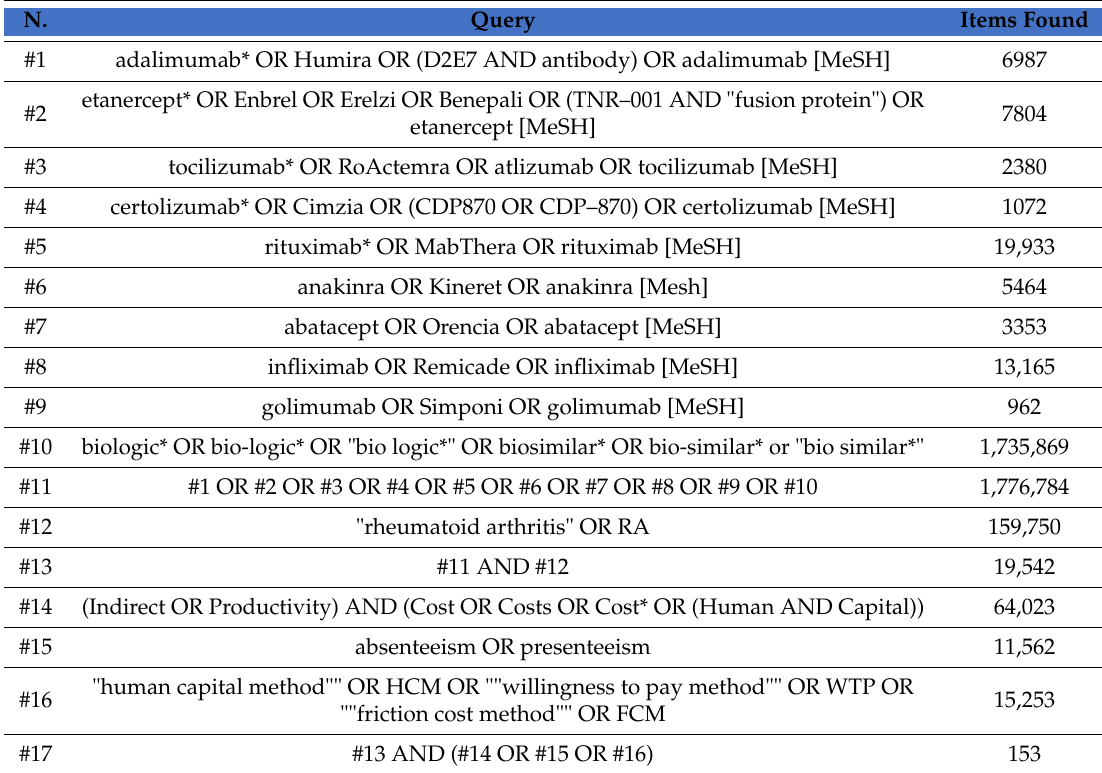
Table A1. Search strategy.